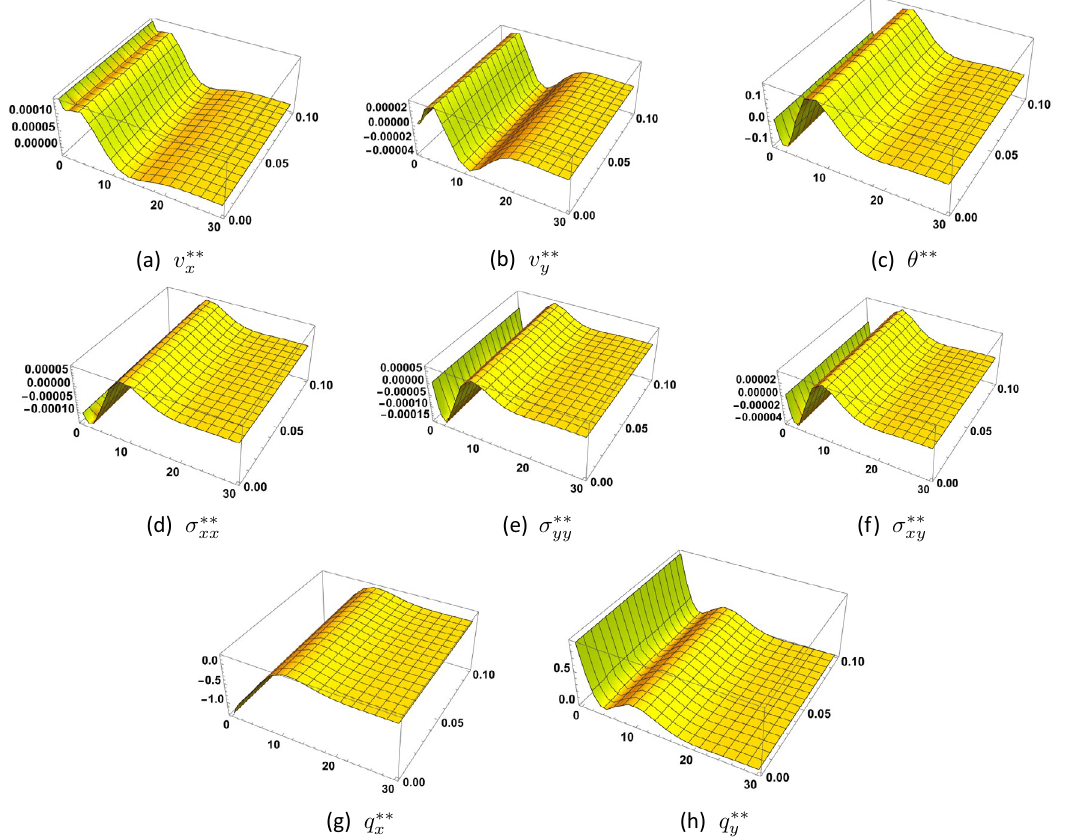
Figure 3. Second order solution as function of ( x , y ) at t = 1.5 , and for τ q = 0.6 , τ θ = 0.5 , η = 1.0